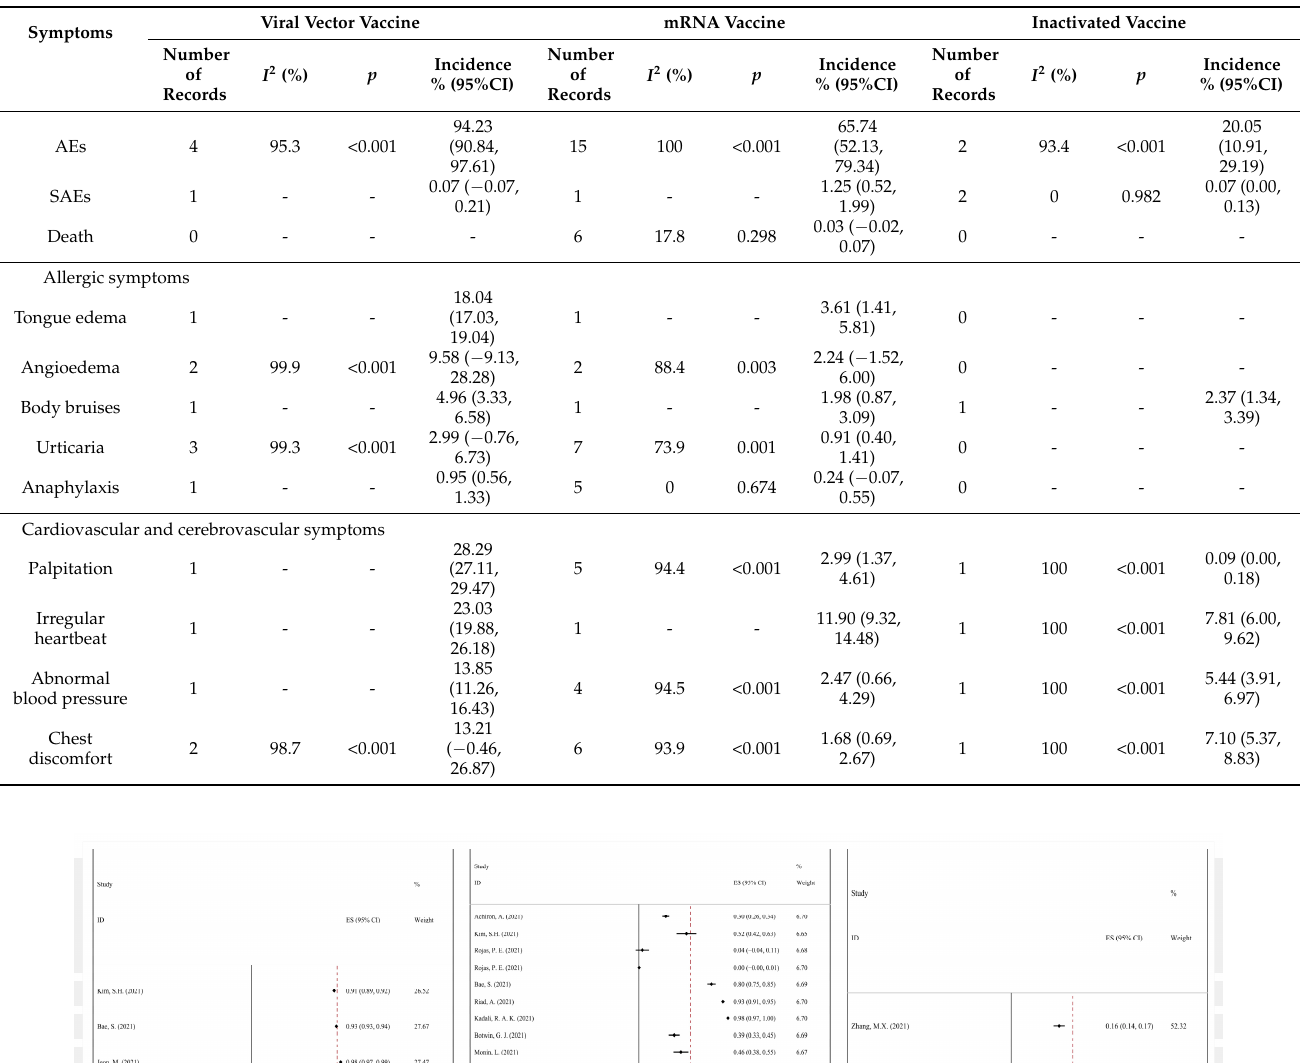
Table 2. Meta-analysis results of incidence of adverse events (AEs) in observational studies.